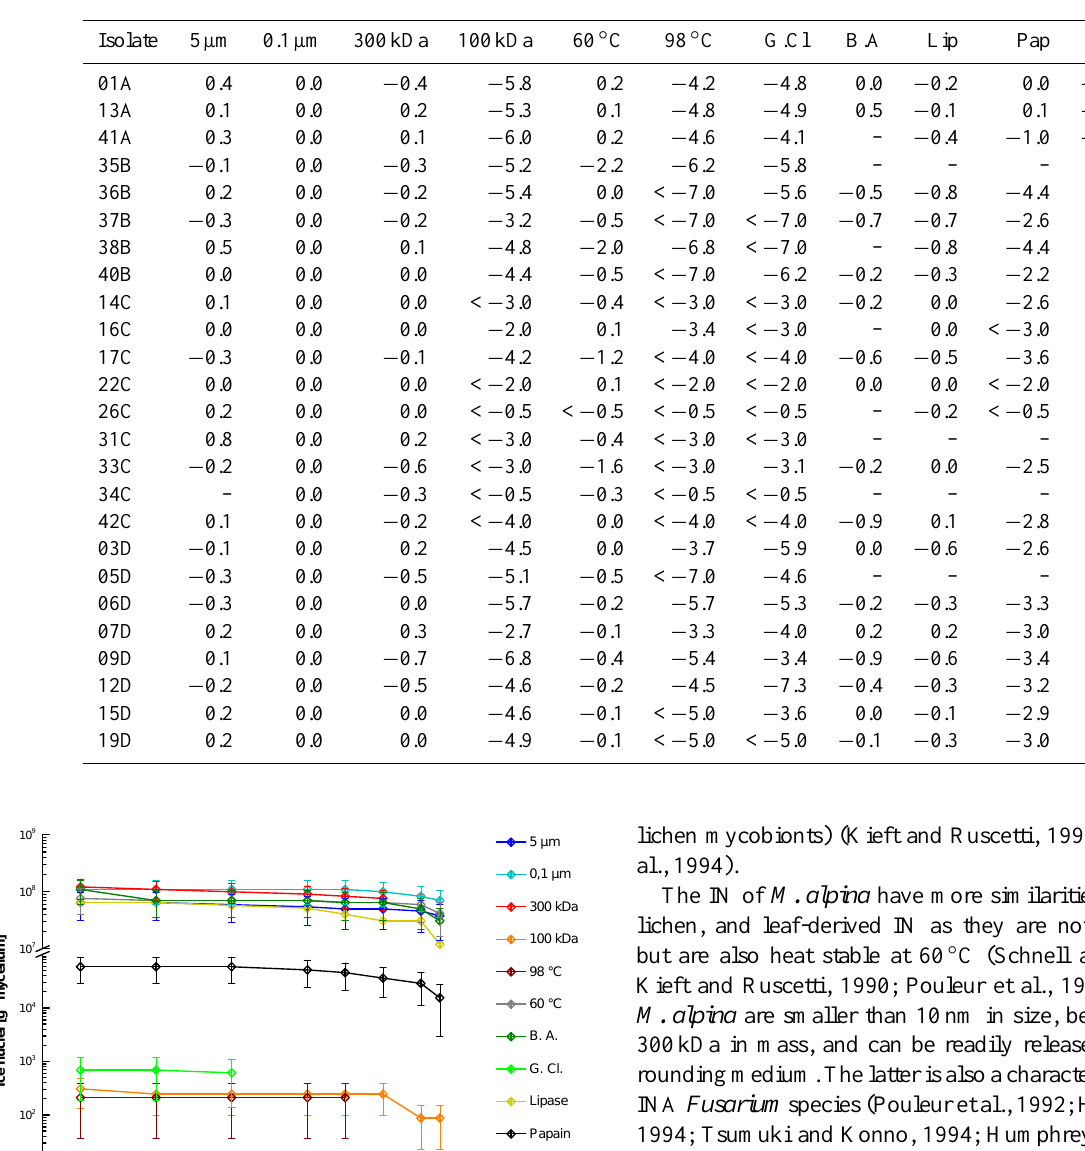
Table 4. Changes of number of IN in orders of magnitude after filtration (5, 0.1µm; 300, 100kDa), thermal (60, 98 ◦ C), chemical (guani- dinium chloride (G.Cl) or boric acid (B.A)), or enzymatic (lipase, papain, pepsin) treatments at − 11 ◦ C relative to the activity of the 0.1µm filtrate of selected M. alpina isolates; dashes mean not measured.